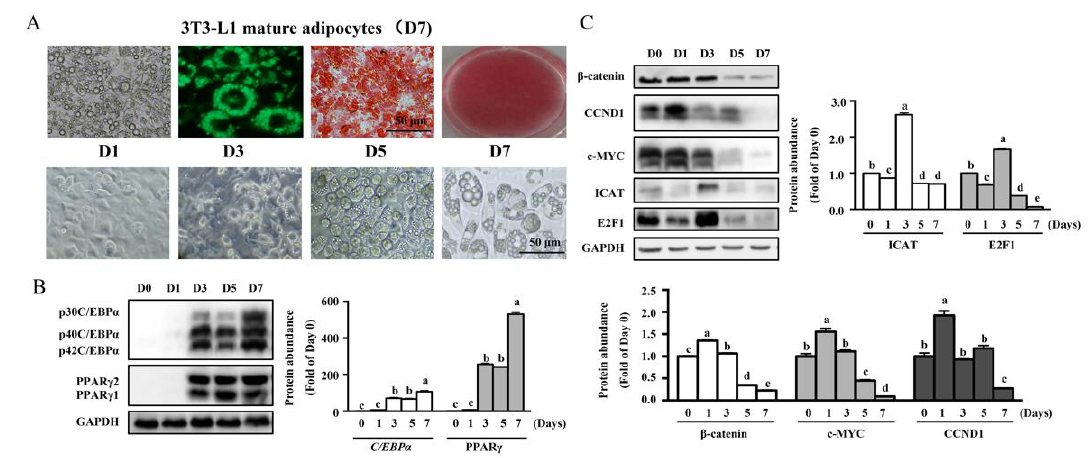
Figure 1. 3T3-L1 cell di ff erentiation was associated with an increased protein level of E2F1 and